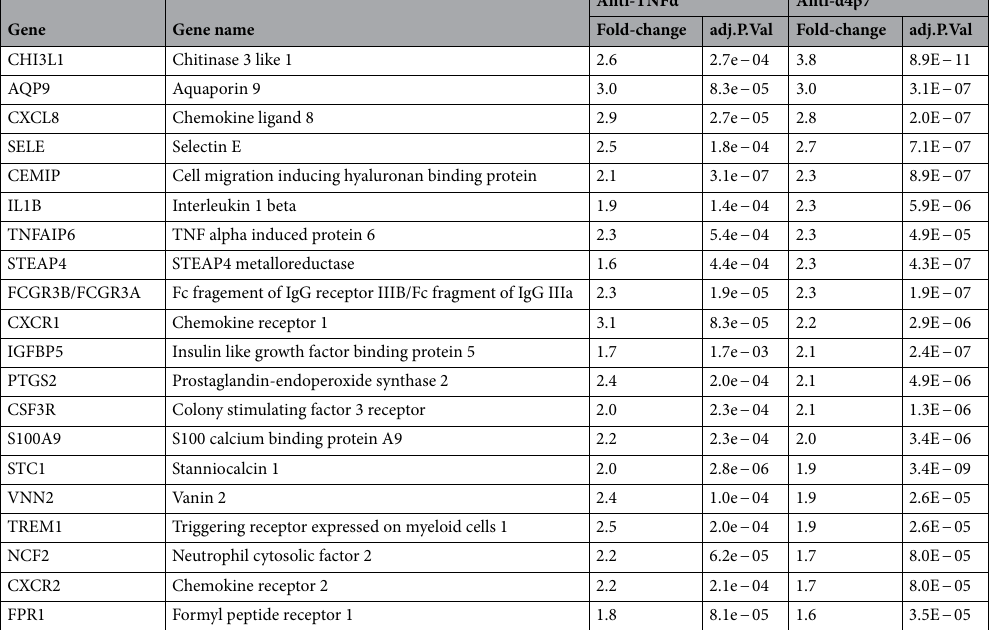
Table 1. UC 20R resistance gene signature representing the top 20 differentially expressed genes from UC tissue of patients non-responsive to both biologic anti-TNFα and anti-α4β7 compared to responders. (GSE73661) (GSE12251) (n = 25 non-responders, 21 responders for anti-TNFα; n = 35 non-responders, 18 responders for anti-α4β7).